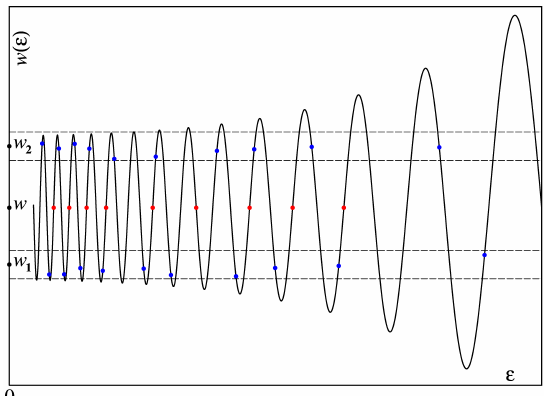
Figure 1. A sketch of behaviour of w ( ε ) when two distinct limit weak solutions to the MHD equations coexist (see the text). Points ( ε k , j , w ( ε k , j )) (blue dots) tend to ( 0, w k ) (black dots) for j → ∞ , k = 1,2. The sequence ( ε 3, j , w ( ε 3, j )) → ( 0, w ) (red dots), where w ( ε 3, j ) = w , exists due to continuity of w ( ε ) in ε for ε > 0. Dashed lines: boundaries of the regions | w − w k | ≤ γ